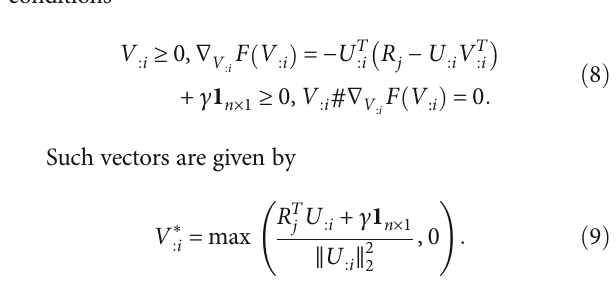
ffiffiffiffiffiffiffiffiffiffiffiffiffiffiffiffiffiffiffiffiffiffiffiffiffiffiffi p k U